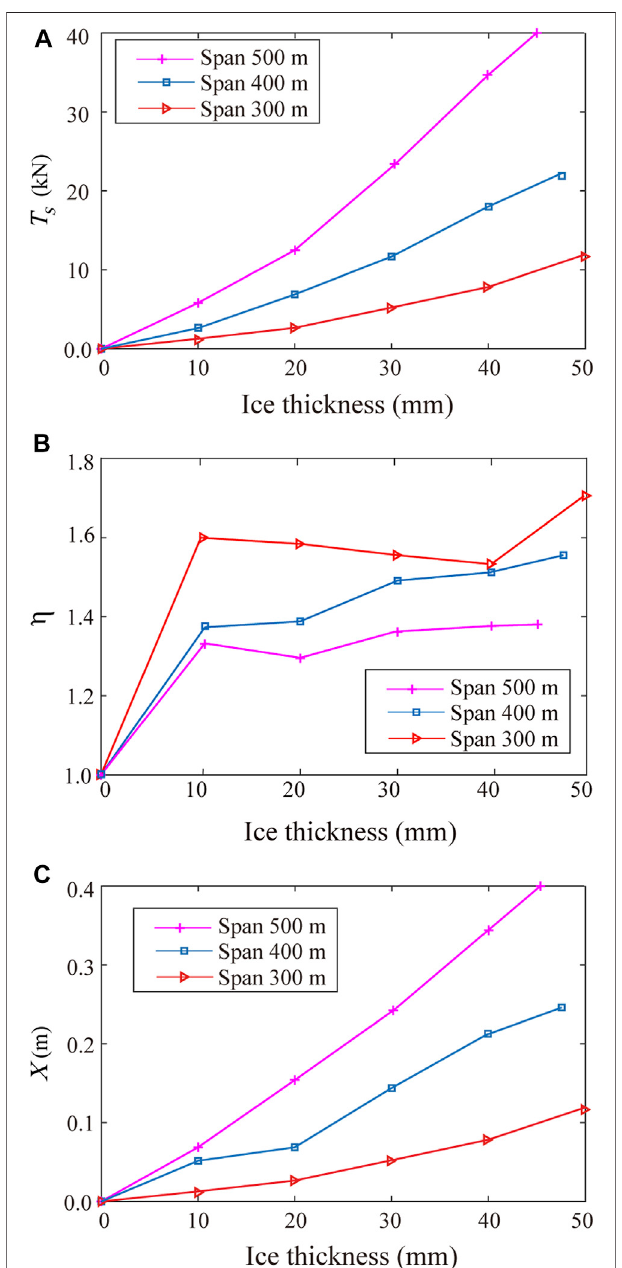
FIGURE 6 | Variations in the responses of the tower-line system with different spans (A) static longitudinal unbalanced tension (B) impact coef fi cient of the unbalanced tension (C) displacement of Point K.